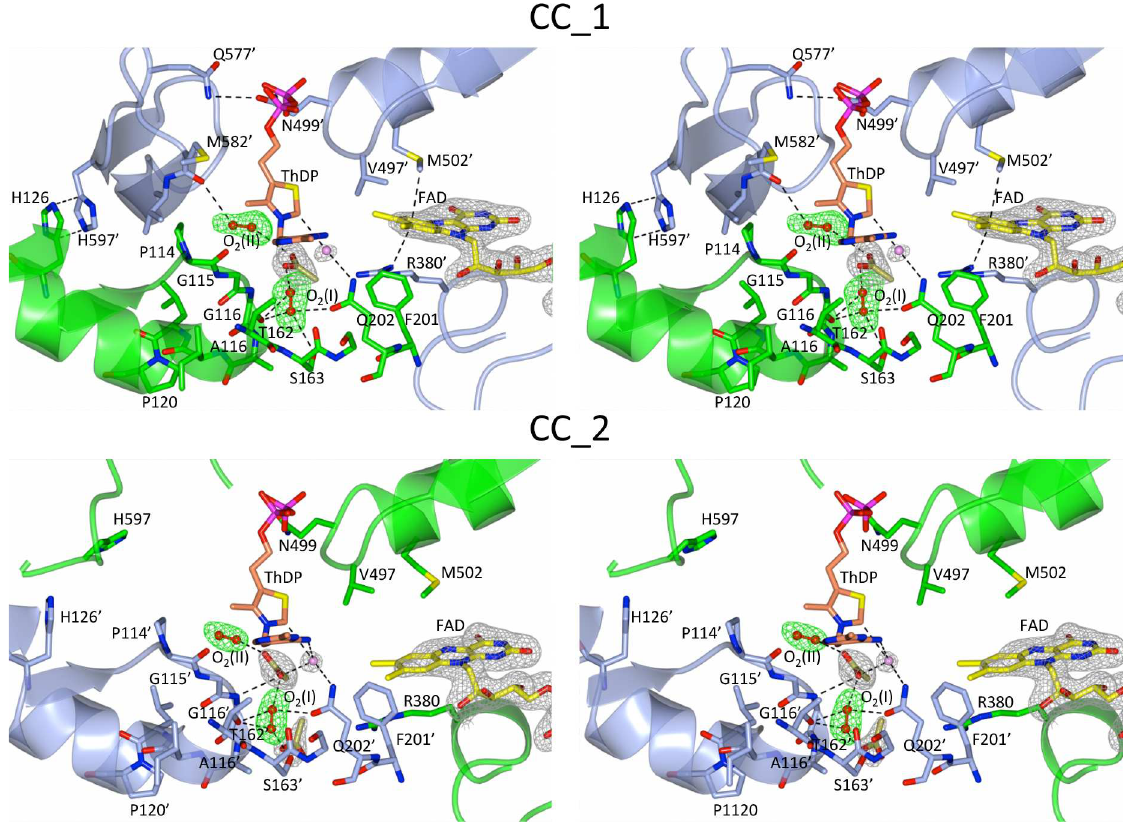
Fig 2. Stereo views of the structure of the Sc AHAShomodimer showing that different conformations occur in the catalytic centres, CC_1 and CC_2. The two polypeptide chains are colouredgreen and ice blue. The pink sphererepresents a water molecule.Dashedblack lines represent interactions occurring betweenthe different moleculesin the active site, including hydrogen bonds, van der Waals and hydrophobic interactions. Green electron densities(contoured at 3.5 σ in the F o —F c map) correspond to the two O 2 molecules.Grey electrondensities(2F o —F c map) correspondto acetate and FAD moleculescontoured at 1.5 σ .